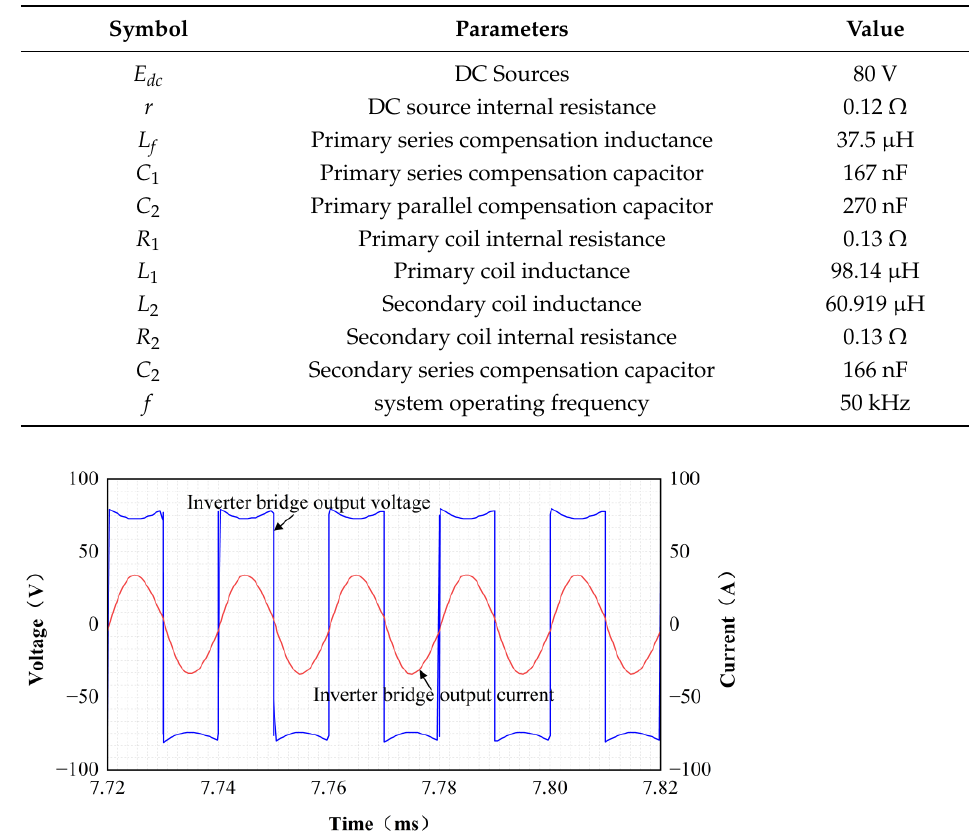
Figure 12. Inverter output voltage and current simulation waveforms.